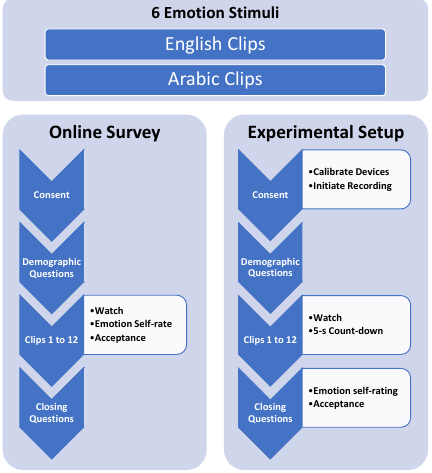
Figure 1. Current research methodology